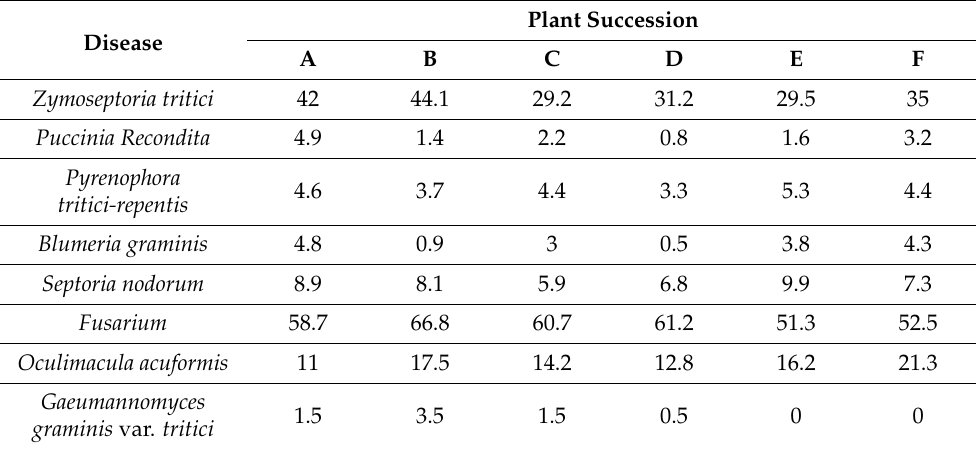
Table 2. Disease severity in winter wheat (infection index in %)—average for 2003–2005. Reprinted from reference [85].